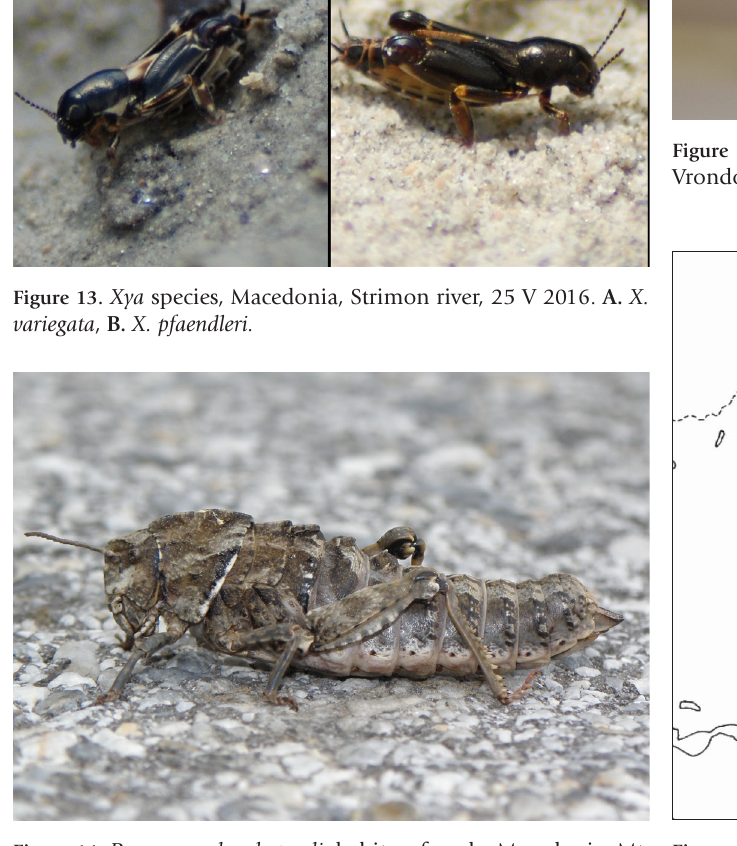
Figure 14. Paranocarodes chopardi , habitus, female, Macedonia, Mt. Vrondous, 19 V 2016.